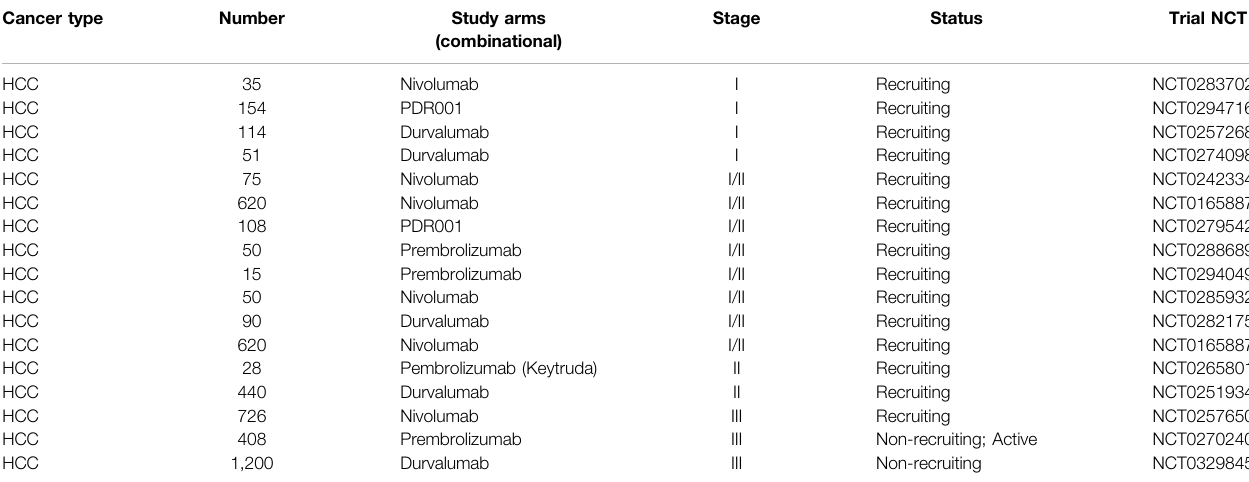
TABLE 2 | Clinical trials with PD-1/PD-L1 therapy against liver cancer. Cancer